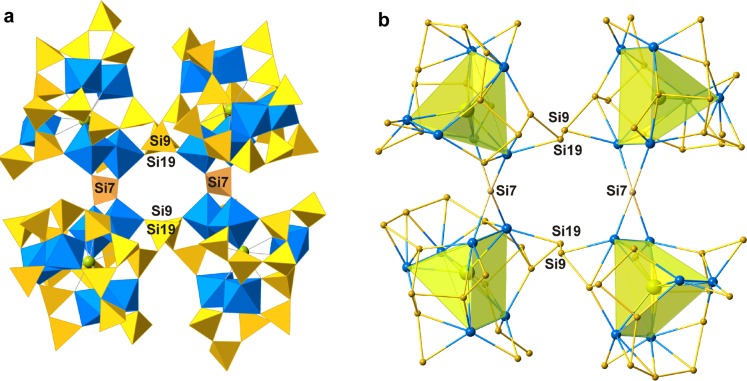
Four-membered ring of the TPTS clusters shown in (a) polyhedral and (b) nodal representations. Legend and numbering scheme follow that of Fig. 1 ▸.